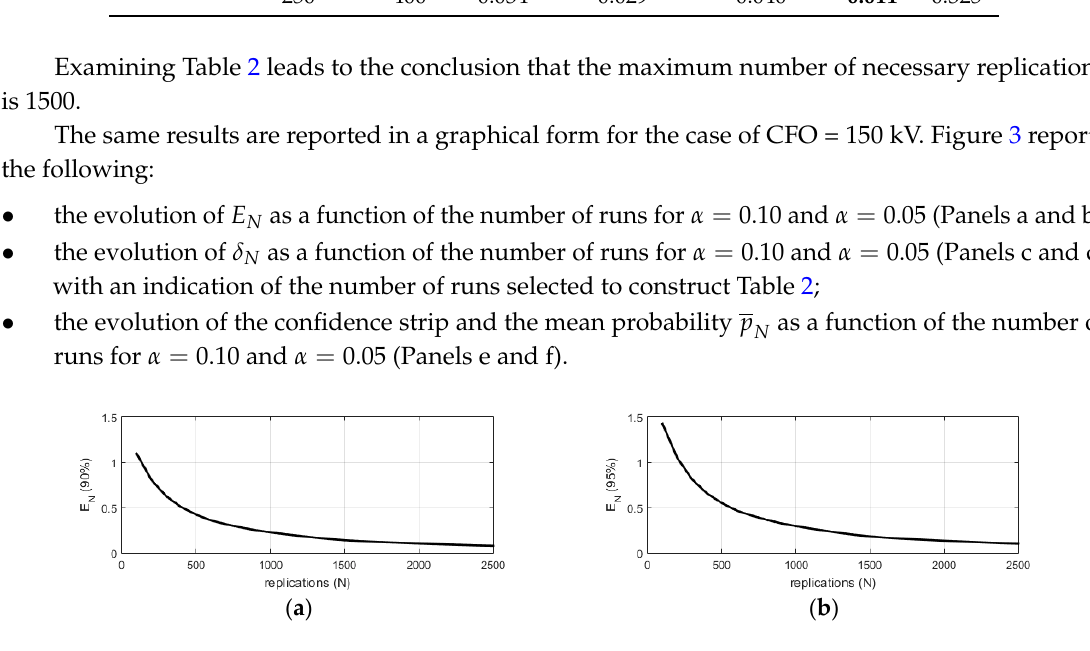
Figure 3. Cont. Figure 3.